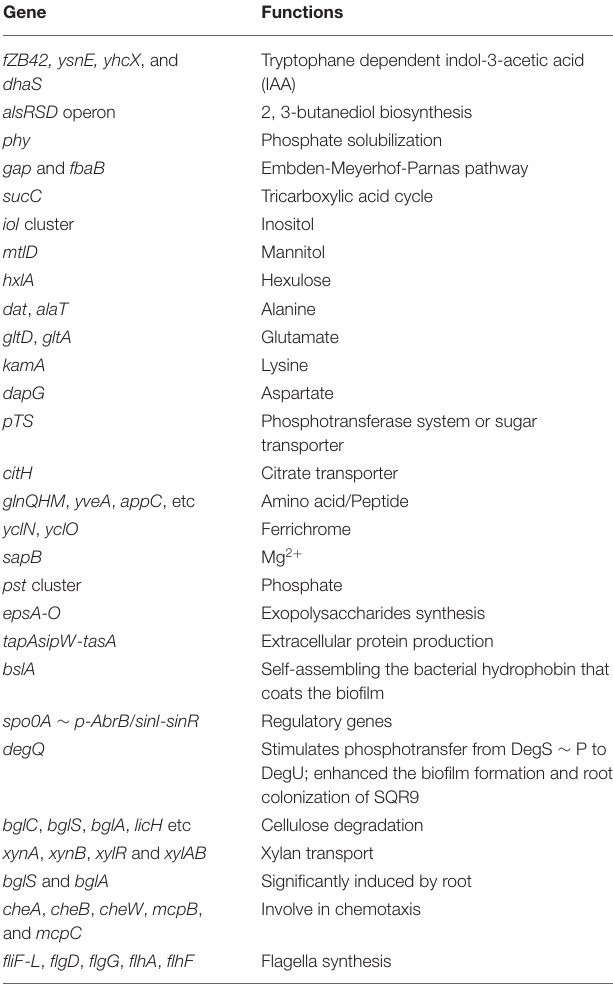
TABLE 2 | Root exudates of maize plant recruit B. amyloliquefaciens strain. The whole genome sequence of B. amyloliquefaciens revealed that the group of genes induced by root exudates and its functional gene triggers rhizoadaptation, phytostimulation, bioferlilizer, and biocontrol